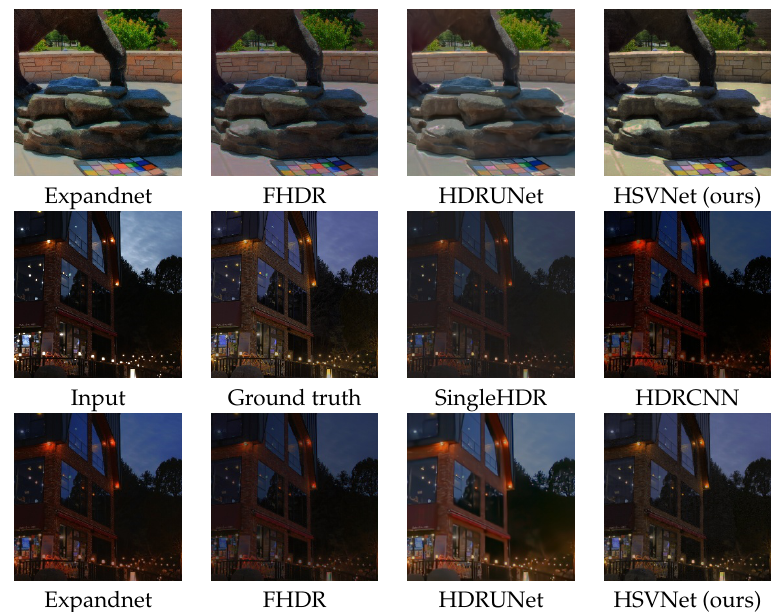
Figure 12. The result images generated by our method HSVNet and existing methods. The first and the second images are LDR input and the corresponding ground truth HDR images. The next images are the result images from existing methods, SingleHDR, HDRCNN, Expandnet, FHDR, and HDRUNet, respectively. The last image is our HSVNet result image.